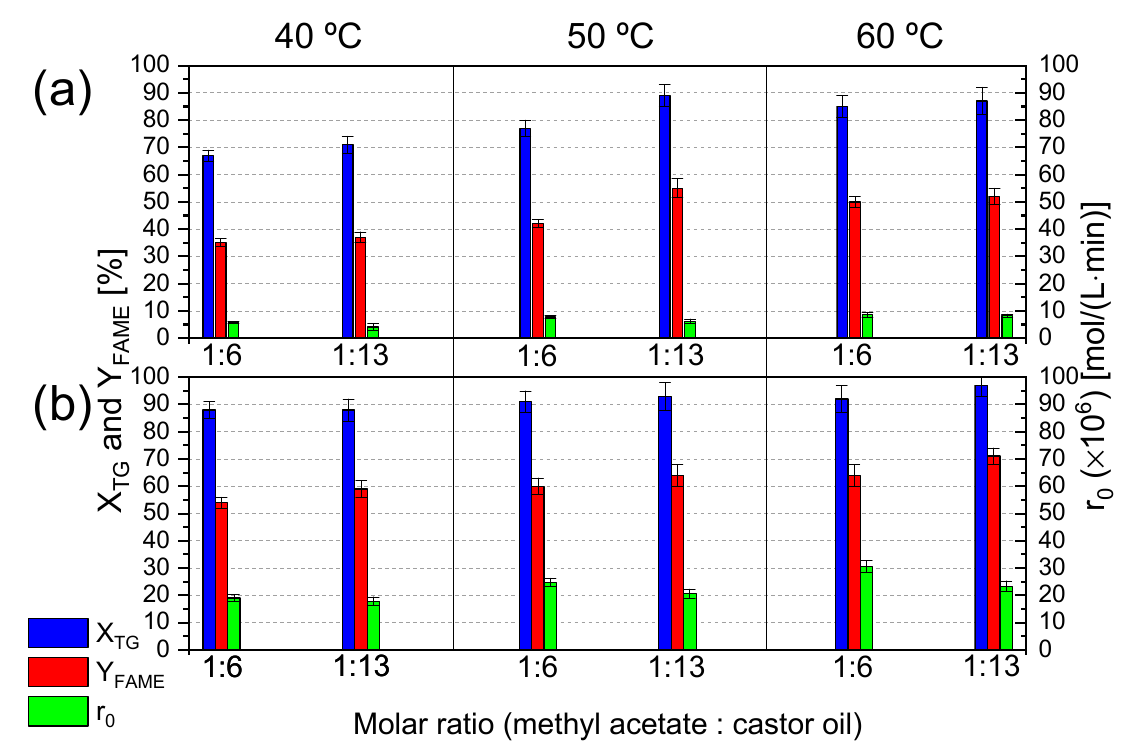
Figure 2. Effects of the main operational conditions (substrate molar ratio, temperature, and enzyme concentration) on the triglyceride in castor oil at 24 h and on the initial reaction rate (r 0 ) at an enzyme concentration of ( a ) 10% w/w oil, and ( b ) 30% w/w oil.